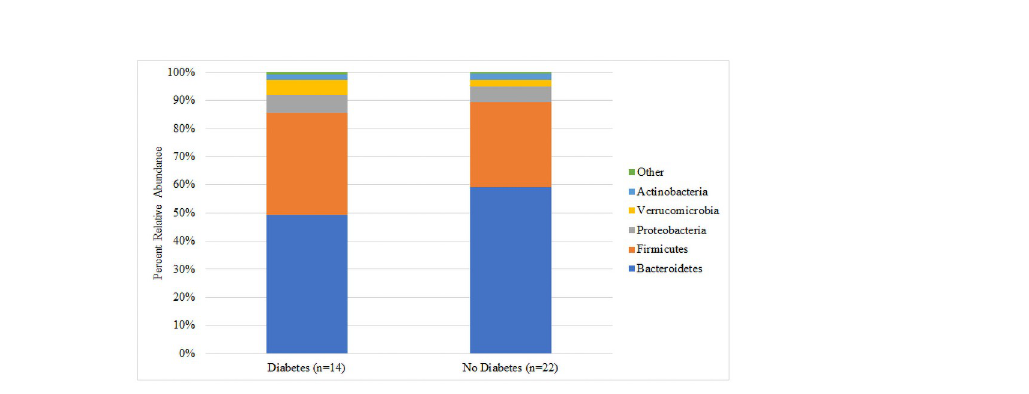
Fig 2. Percent relative abundance of bacterial phyla by diabetes status.